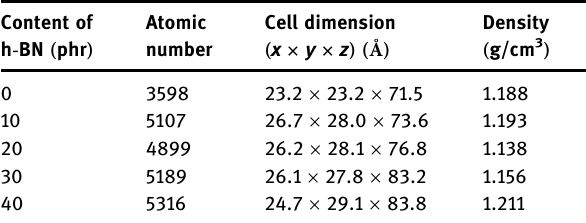
Table 2: Structuralparametersofthermalconductivitycalculationmodel Content of h - BN ( phr